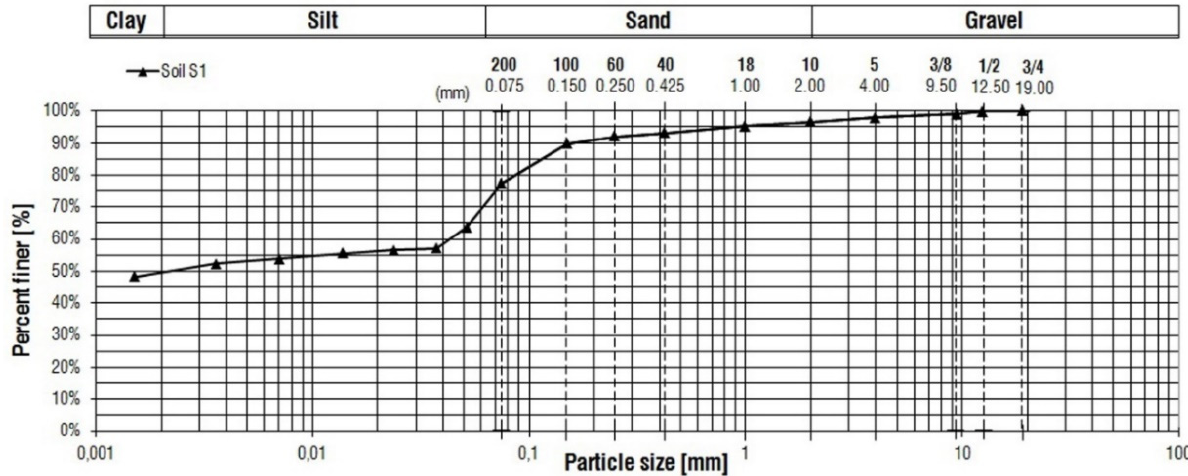
Figure 3. Grain–size curve of the earth under exam S1; Particle size analysis was carried out on different samples relative to the local soil with starting mass of about 1.7 Kg.